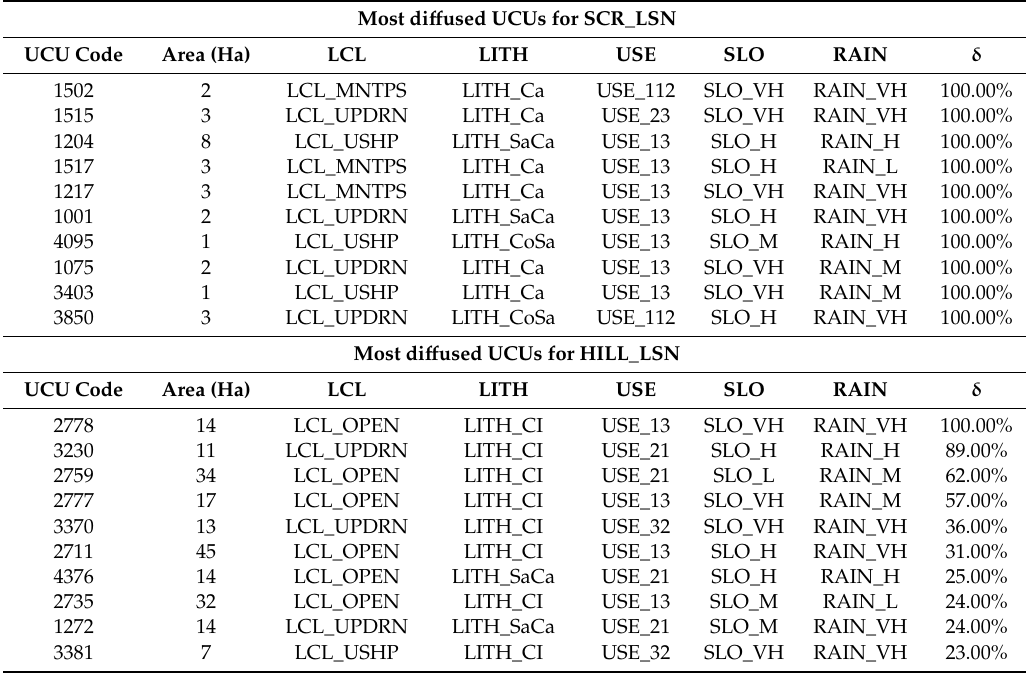
Table 3. Most susceptible unique conditions units (UCUs) in the target